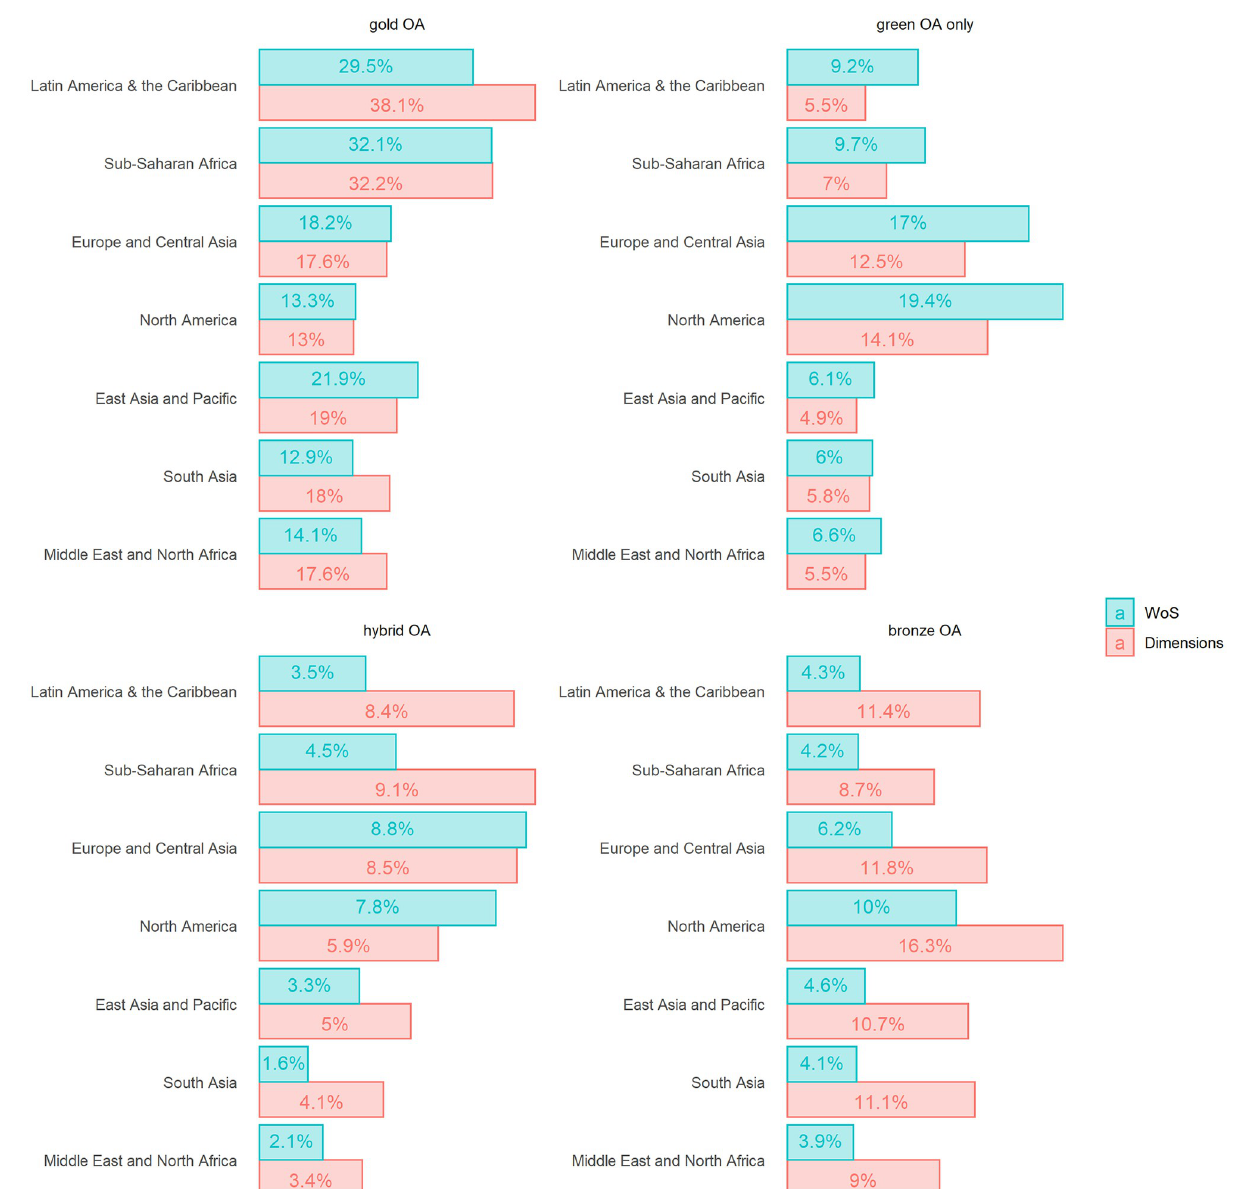
Fig 3. Percentage of open access publications, by region, open access type and database, 2015–2019. Sub-Saharan Africa (+0.3). However, it is higher in WoS for East Asia and Pacific (+13.2), with only a slight difference for Europe and Central Asia (+3.3), and North America (+2.3%). For Asia and the regions in the southern hemisphere, very few publications ( < 10%) are green only OA. For almost all regions, a larger percentage of publications in WoS are green only OA than in Dimensions. The exception is South Asia (+3.3), with only a slight difference in favour of Dimensions. The percentage of hybrid OA is low ( < 10%) for all regions, regardless of database used. The percentage of hybrid OA is higher in WoS for both North America (+24.4%) and, to a lesser extent, Europe and Central Asia (+3.4). For all other regions, the percentage is higher